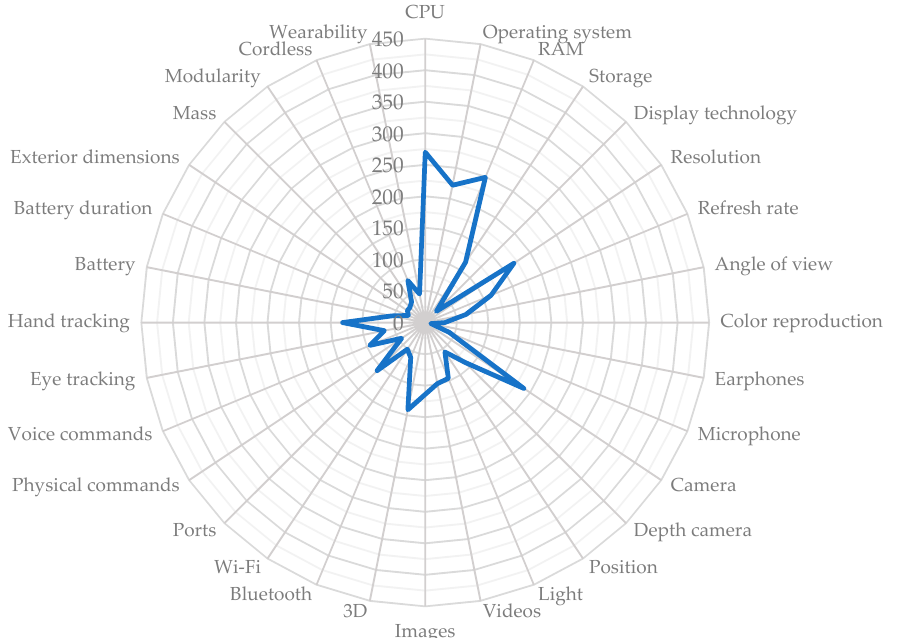
Figure 6. Device specification relative importance for maxillofacial trauma surgery.